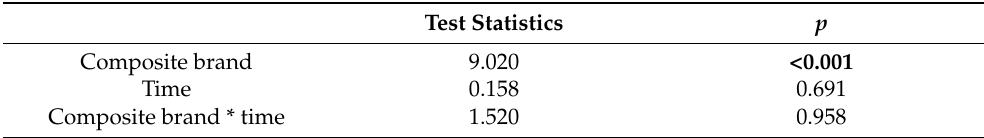
Table 6. Comparison of E M values according to composite brand and